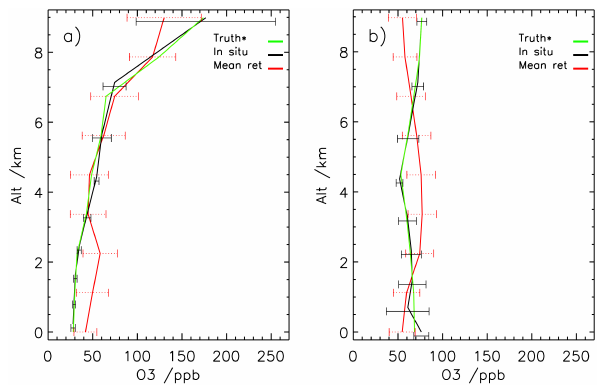
Figure 13. Example retrieval metrics for O 3 during flight B719 over sea at 8.3km altitude showing (a) measured (ARIES) and fit- ted spectra, (b) residual difference between the ARIES-measured spectrum and fitted spectrum, (c) averaging kernels (and degrees of freedom, inset), and (d) total and component systematic and random error components.